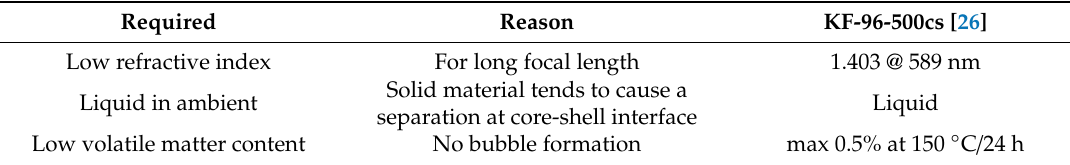
Table 2. Core material requirements and KF-96-500 cs specifications.